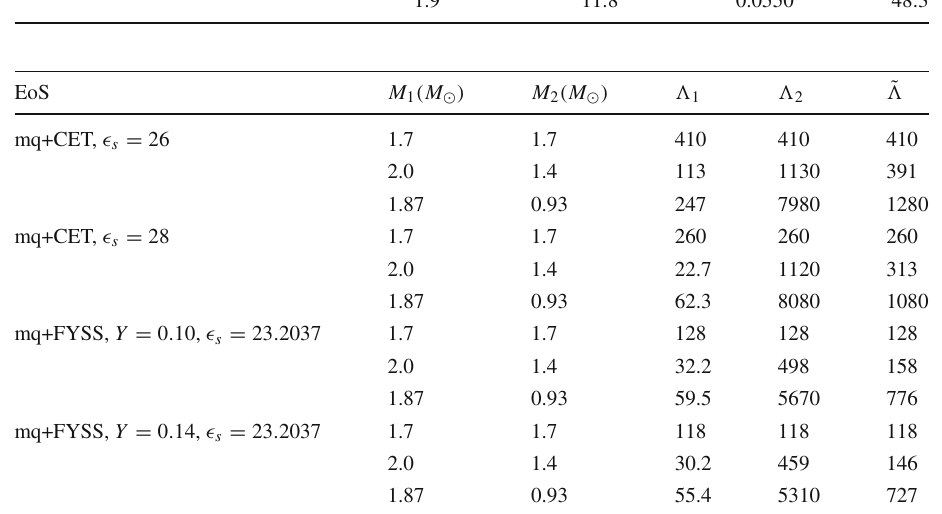
Table 2 Tidal love number k 2 and dimensionless tidal deformation (cid:2) of NS with multiquark core and nuclear CET/FYSS crust